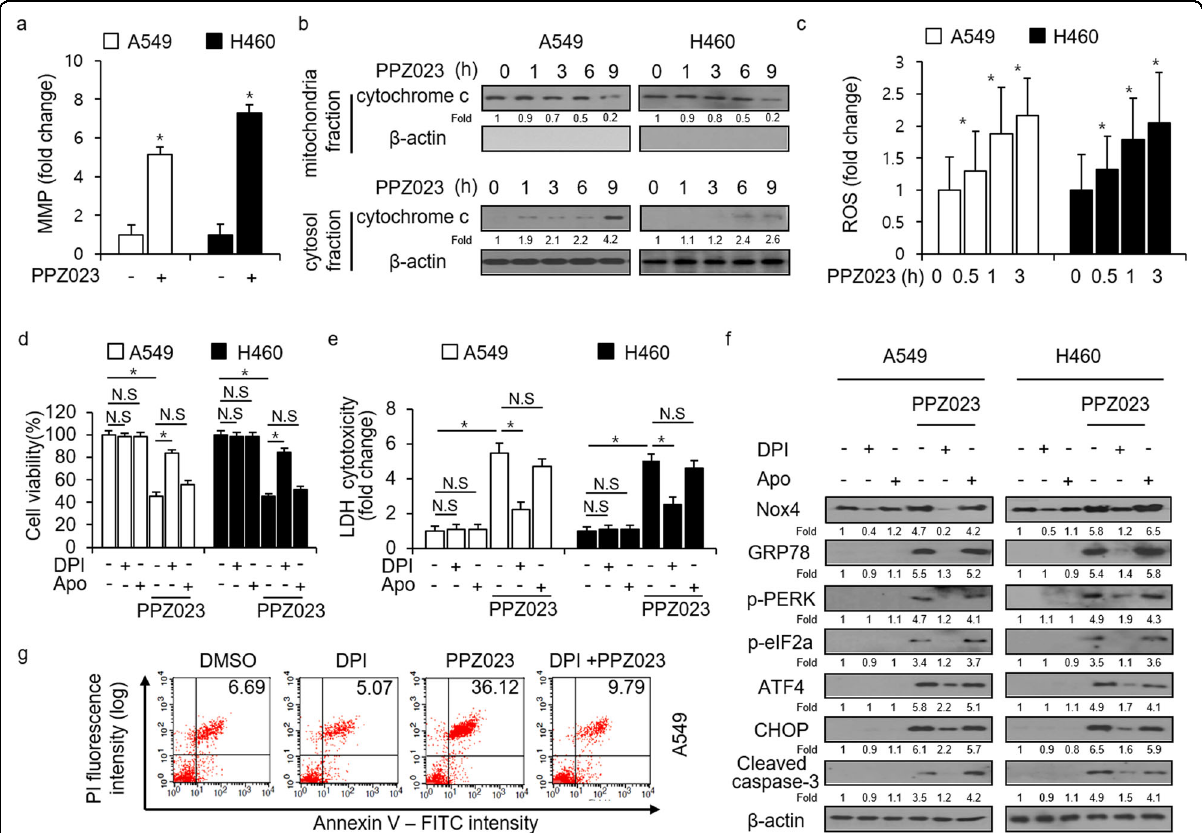
Fig. 5 DPI inhibits PPZ023-mediated cell death in NSCLC cells. a PPZ023-induced ΔΨ m loss was measured after staining A549 and H460 cells with DiOC 6 ; * p < 0.05. b Release of cytochrome c from the cytosol and mitochondrial fraction in A549 and H460 cells treated with PPZ023 (25 μΜ ) for the indicated times; this was detected by western blot analysis. c FACS data indicate changes in the fl uorescence intensity of DCFDA dye in A549 and H460 cells treated with PPZ023 (25 μΜ ) for the indicated times; * p < 0.05. d – f A549 and H460 cells were treated with DPI (1 μ M, 24 h), Apo (100 μ M, 24 h), and PPZ023 (25 μΜ , 24 h). Cell viability was determined using the WST-1 assay, and LDH cytotoxicity was measured using the LDH assay; * p < 0.05. Western blot analyses of GRP78, p-PERK, p-eIF2 ɑ , ATF4, CHOP, and cleaved caspase-3 levels were performed on these samples. β -Actin was used as the protein loading control. g After A549 cells were treated with DPI, PPZ023, or DPI + PPZ023, annexin V FACS analyses were